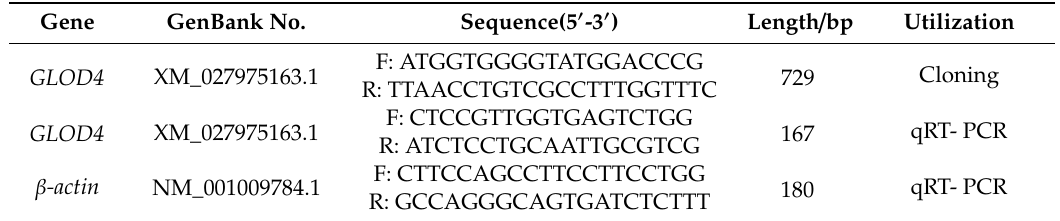
Table 1. The designed